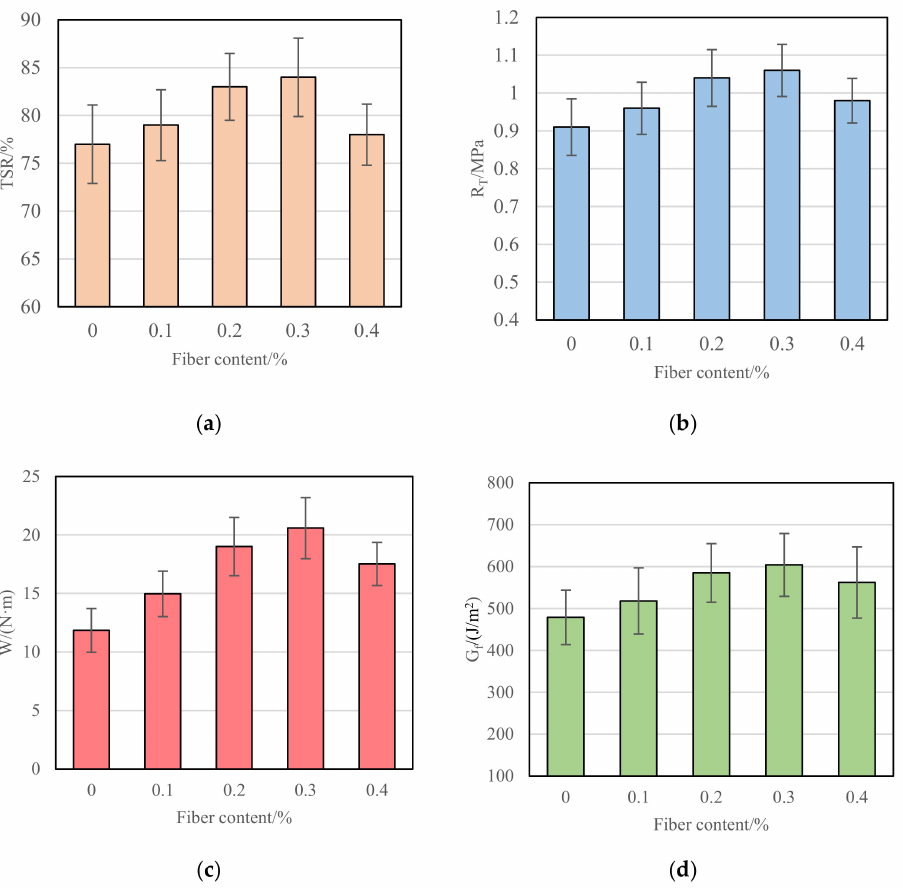
Figure 8. Low-temperature performance of CRM under different fiber contents. ( a ) TSR; ( b ) R T ; ( c ) W; ( d ) G f